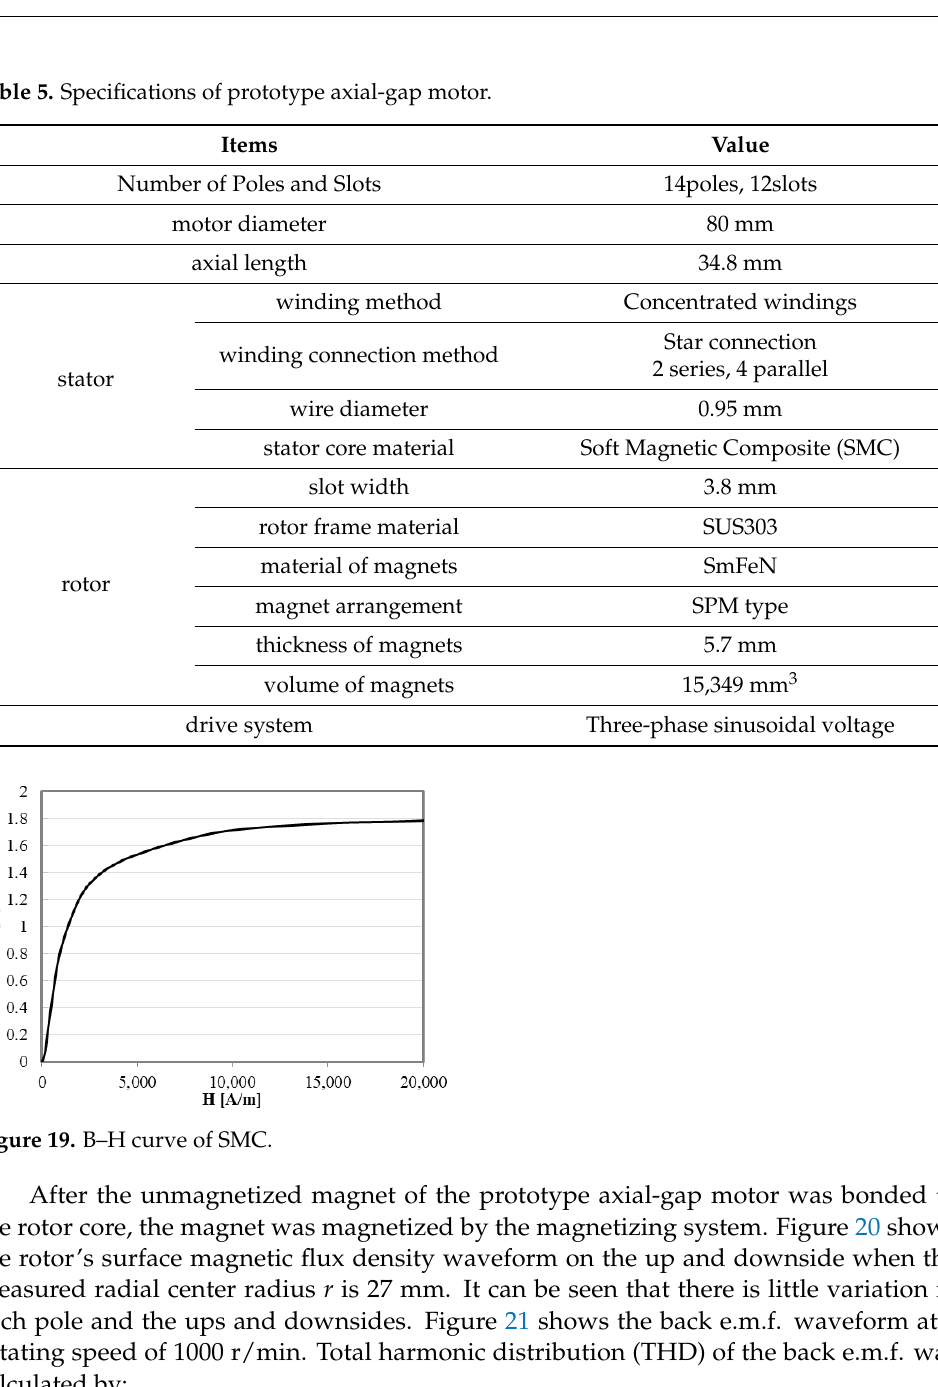
Figure 20. Surface magnetic flux waveform.